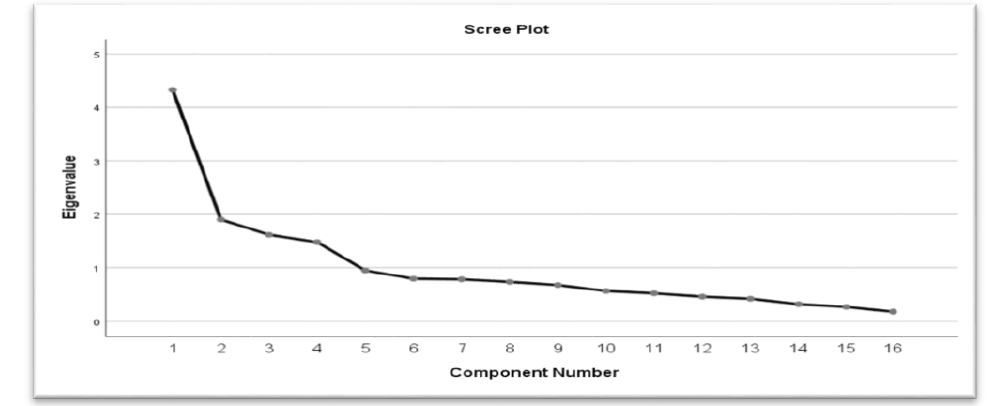
Figure 3: Scree Plot, Component Number and Eigenvalue